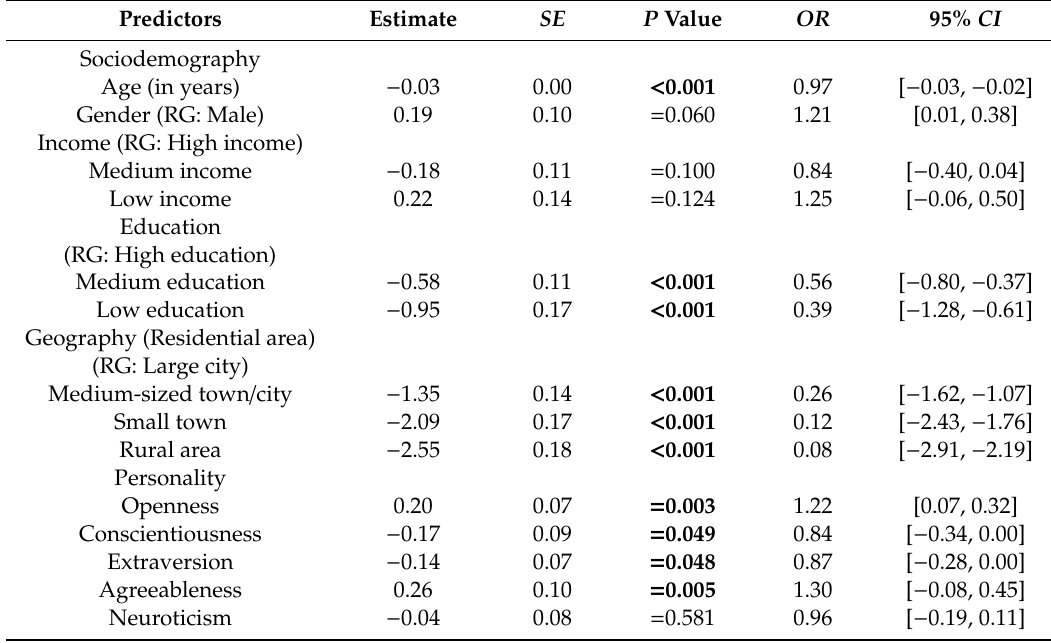
Table 2. Ordinal regression analysis to predict use of public